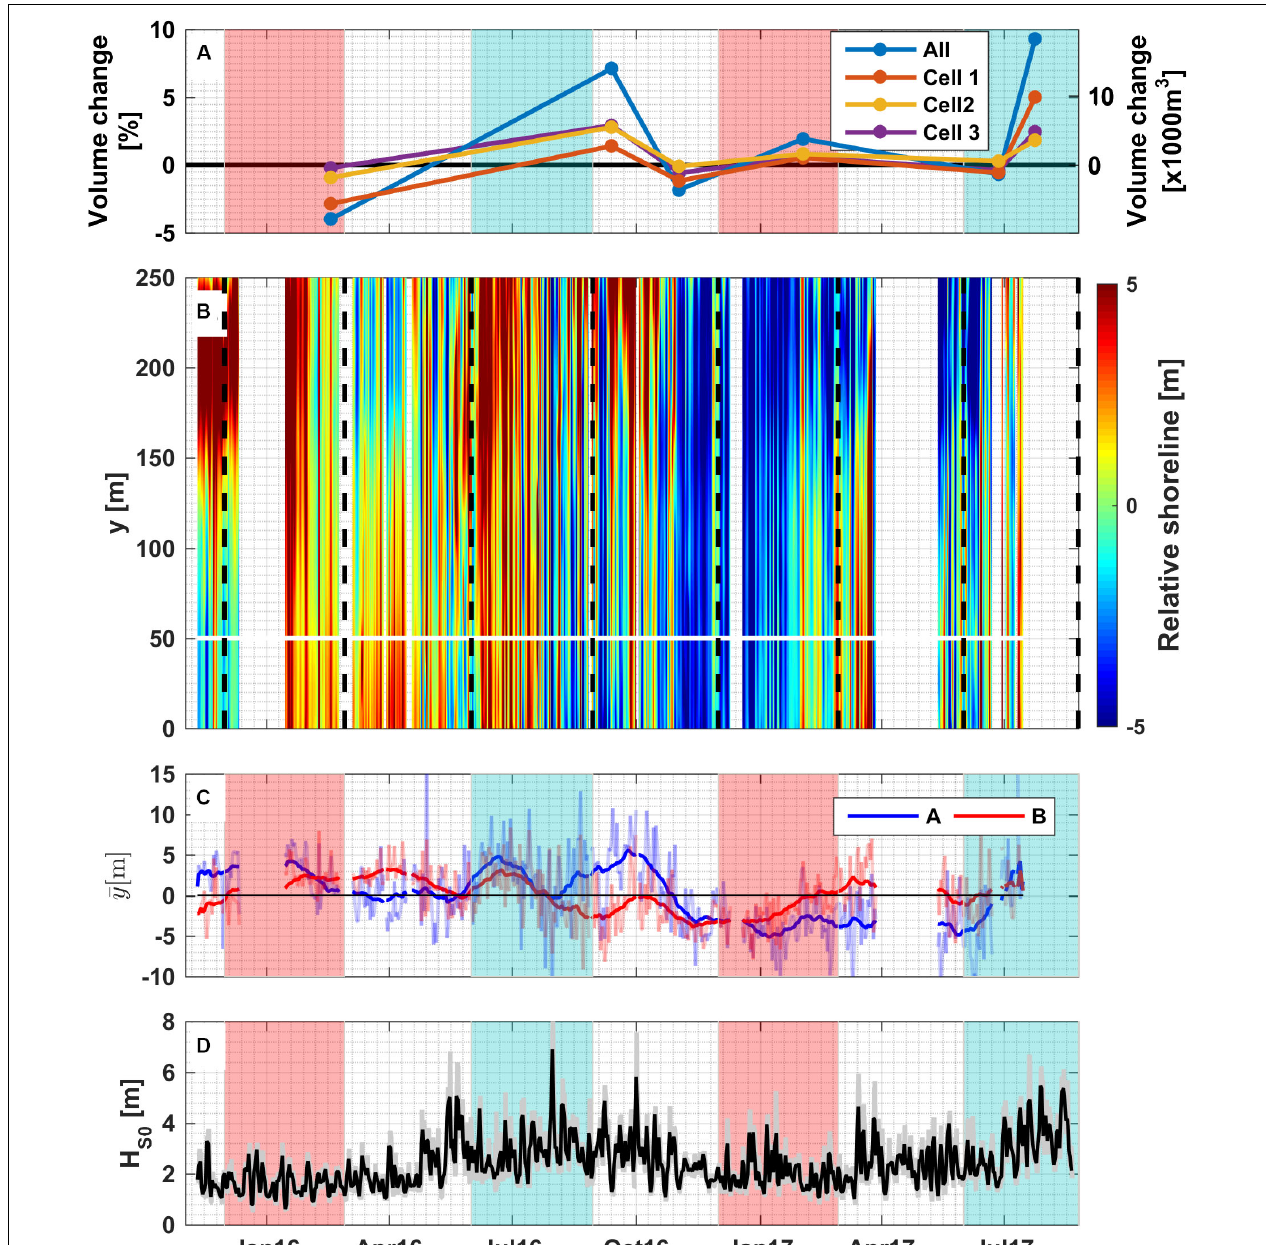
FIGURE 7 | (A) Volume change of the beach between successive topographic surveys in 2015–2017, relative to the initial beach volume in December 2015. The respective primary and secondary y- axis show the beach volume change in percentage relative to initial total beach volume and in 1000 cubic meters. (B) Daily shoreline positions (colors) relative to the mean position over the entire observation period along the 250 m alongshore stretch of beach. A white horizontal line shows the boundary between Cell 3A and B. (C) Daily (thin) and monthly averaged (bold) shoreline positions at 5 m farthest points from the node of part (A) (blue) and (B) (red) which refer to dashed red lines at Figure 1B . Gaps in (B,C) are the periods when video images were unavailable. (D) Daily average (solid black line) and hourly (solid gray line) offshore significant wave height. Transparent red and blue regions as the vertical black dashed lines denote periods of the austral summer and winter,